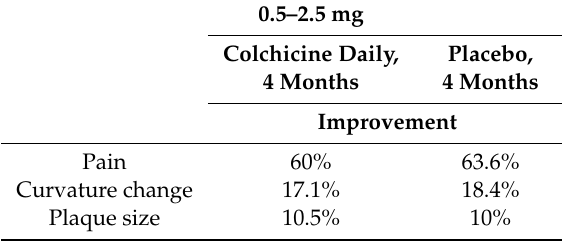
Table 9. Colchicine vs. Placebo: Randomized, Double-Blind,